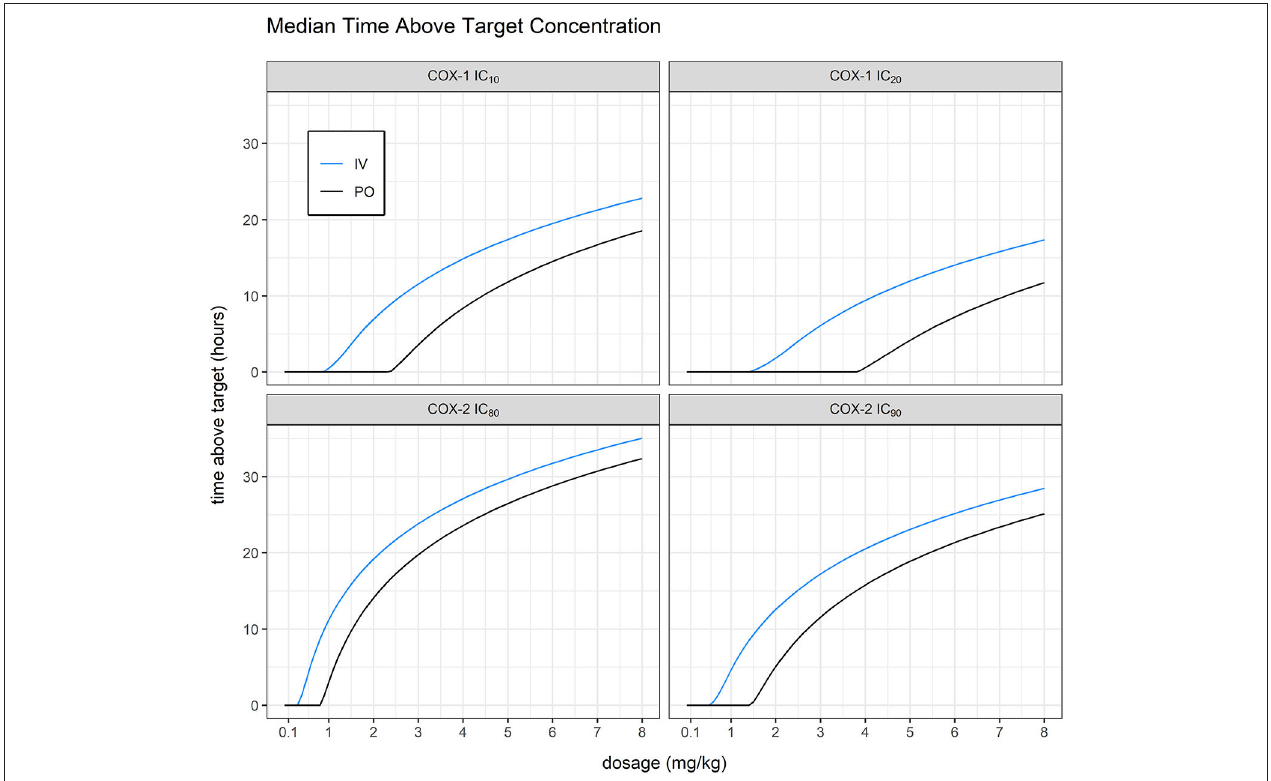
FIGURE 6 | Mean time above target vs. dosage. Simulating without inter-occasion/individual variability, we were able to derive average predicted time above target for IC 10 and IC 20 against COX-1 (911.28 and 1467.8ng/ml, in-house unpublished data) and IC 80 and IC 90 against COX-2 (313.03 and 556.512ng/ml, in-house unpublished data). Model-derived simulations showed that an oral dose of vitacoxib at 2 mg/kg produced systemic concentrations above the IC 80 of COX-2 for ∼ 12h, with no effect on